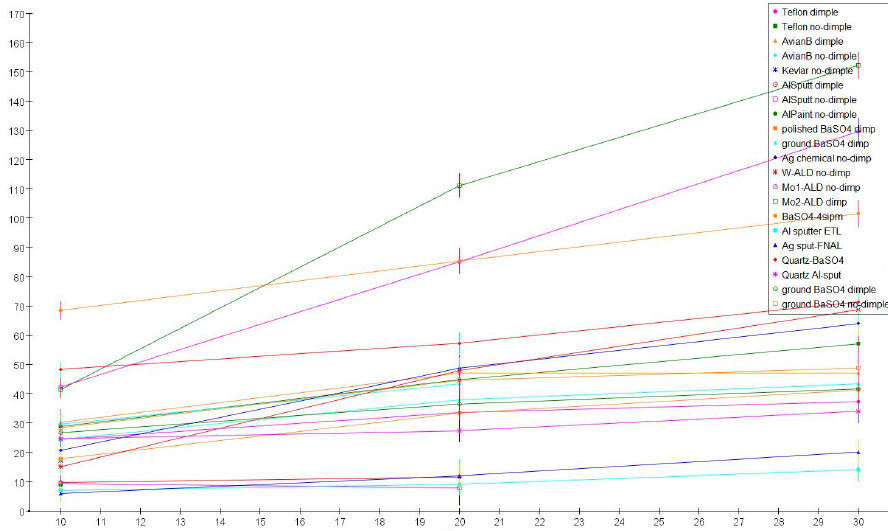
Figure 6. Light yield for 21 groups of tiles corresponding to several surface finish and